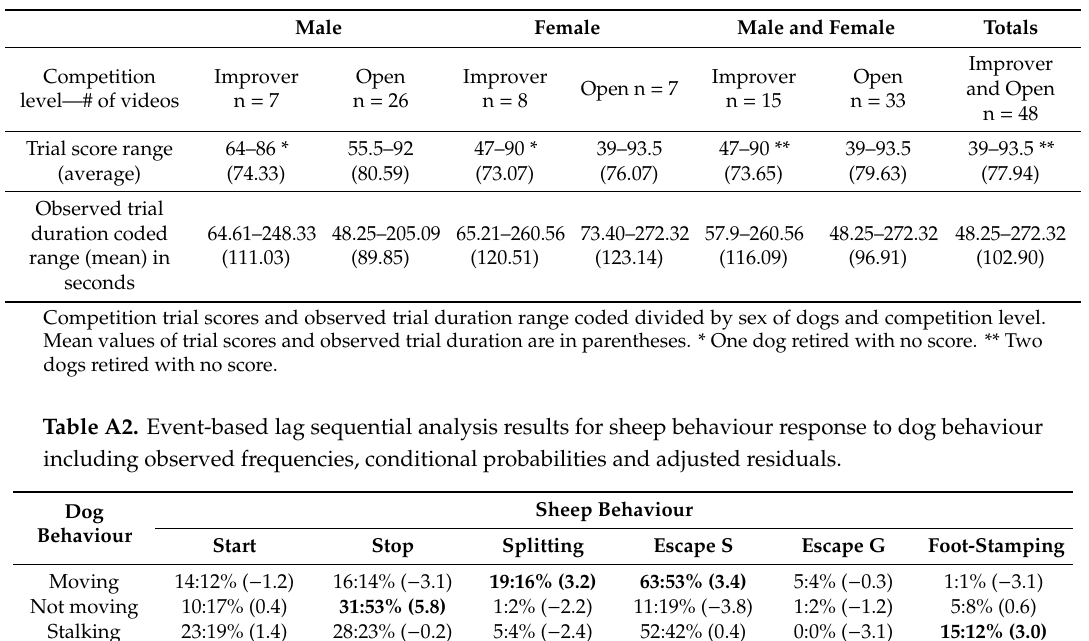
TableA1. Competitiontrialresultssummary: Competitionlevel; TrialscoreandObservedtrialduration.